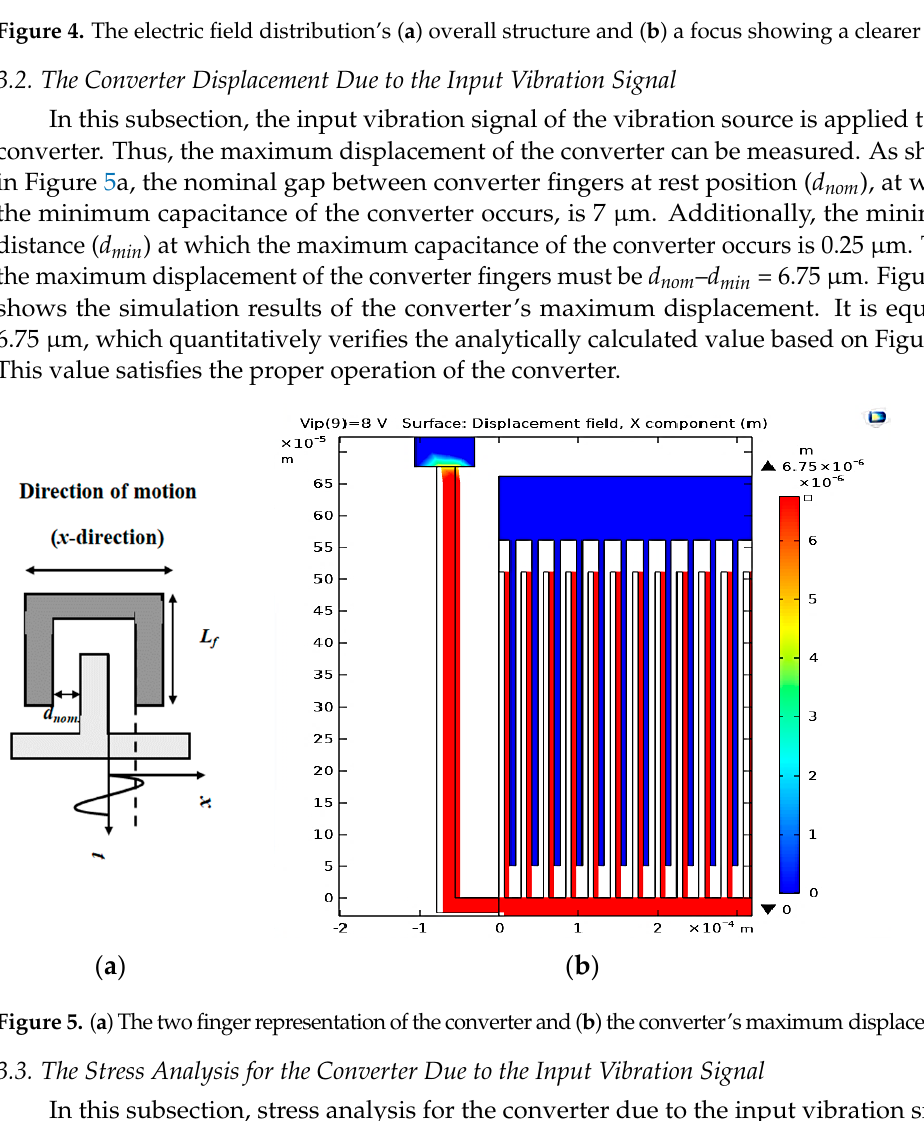
Figure 4. The electric field distribution’s ( a ) overall structure and ( b ) a focus showing a clearer view.